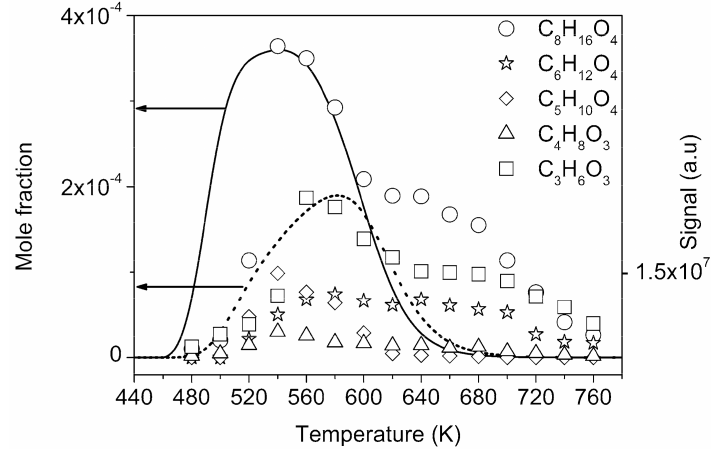
Figure 3. Comparison of the mole fraction profiles for the C 3 H 6 O 3 , C 4 H 8 O 3 , C 5 H 10 O 4 , C 6 H 12 O 4 , and C 8 H 16 O 4 KHPs formed during the low-temperature oxidation of 2500 ppm of DBE. The continuous line represents the computed C 8 H 16 O 4 mole fractions, while the dashed line represents the computed C 3 H 6 O 3 mole fractions. Experimental data are represented by symbols.